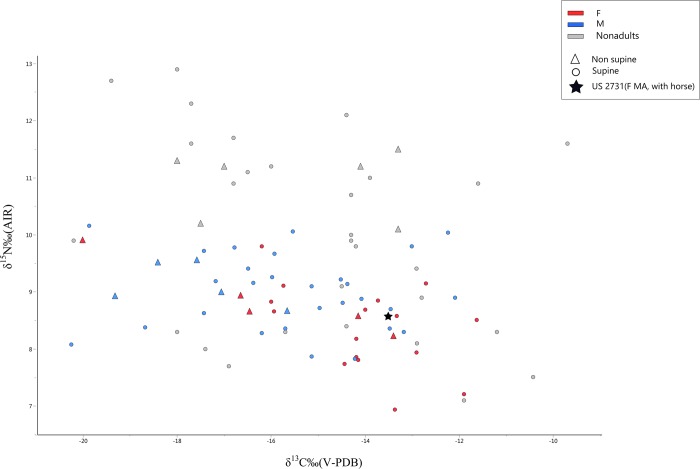
Plot of δ15N vs. δ13C values.Colors indicate sexes. Triangles: non-supine burials, Star: female burial with horse.